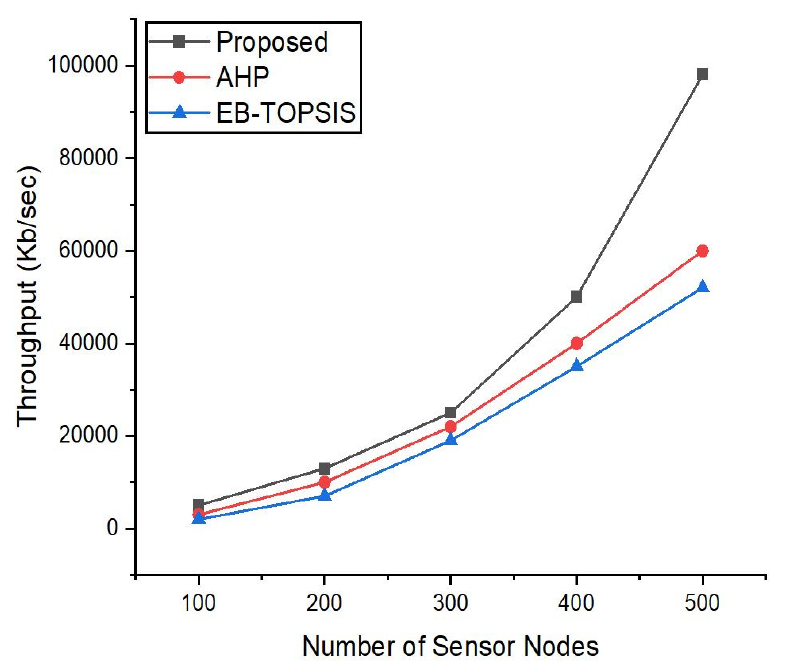
Figure 6. Throughput evaluation of the proposed scheme and previous approach.